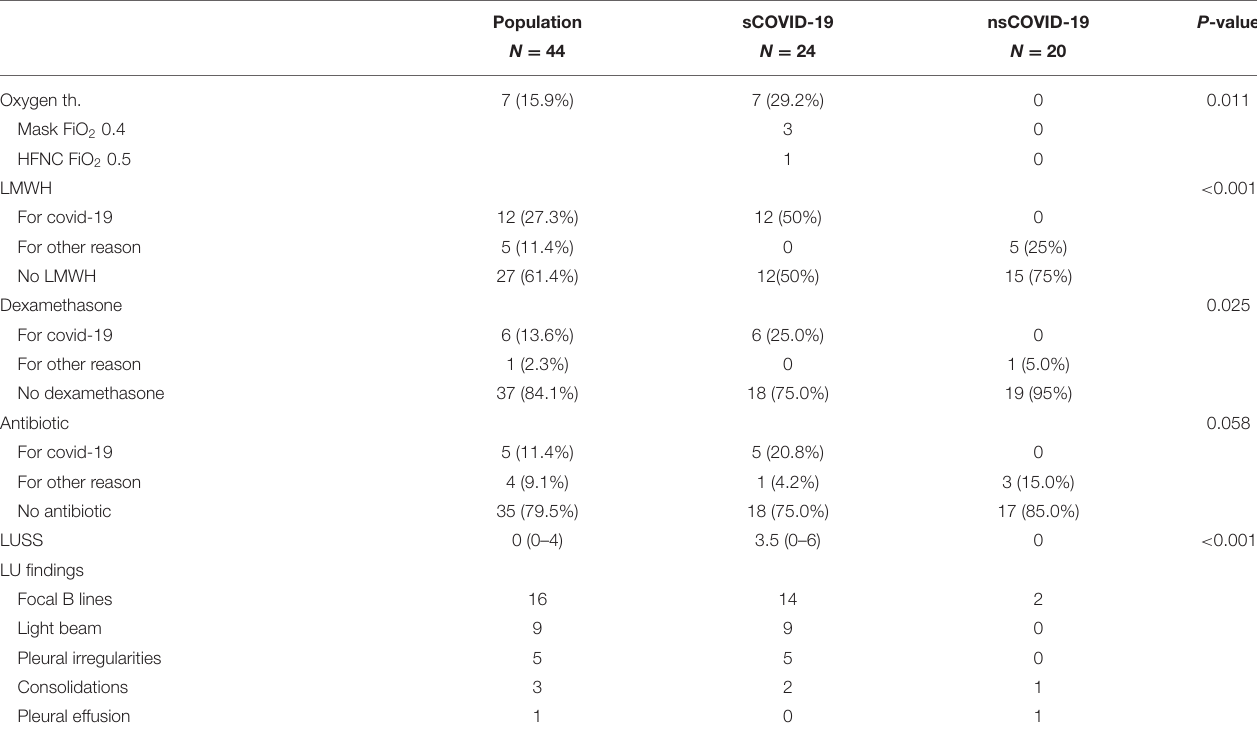
Frontiers in Medicine |